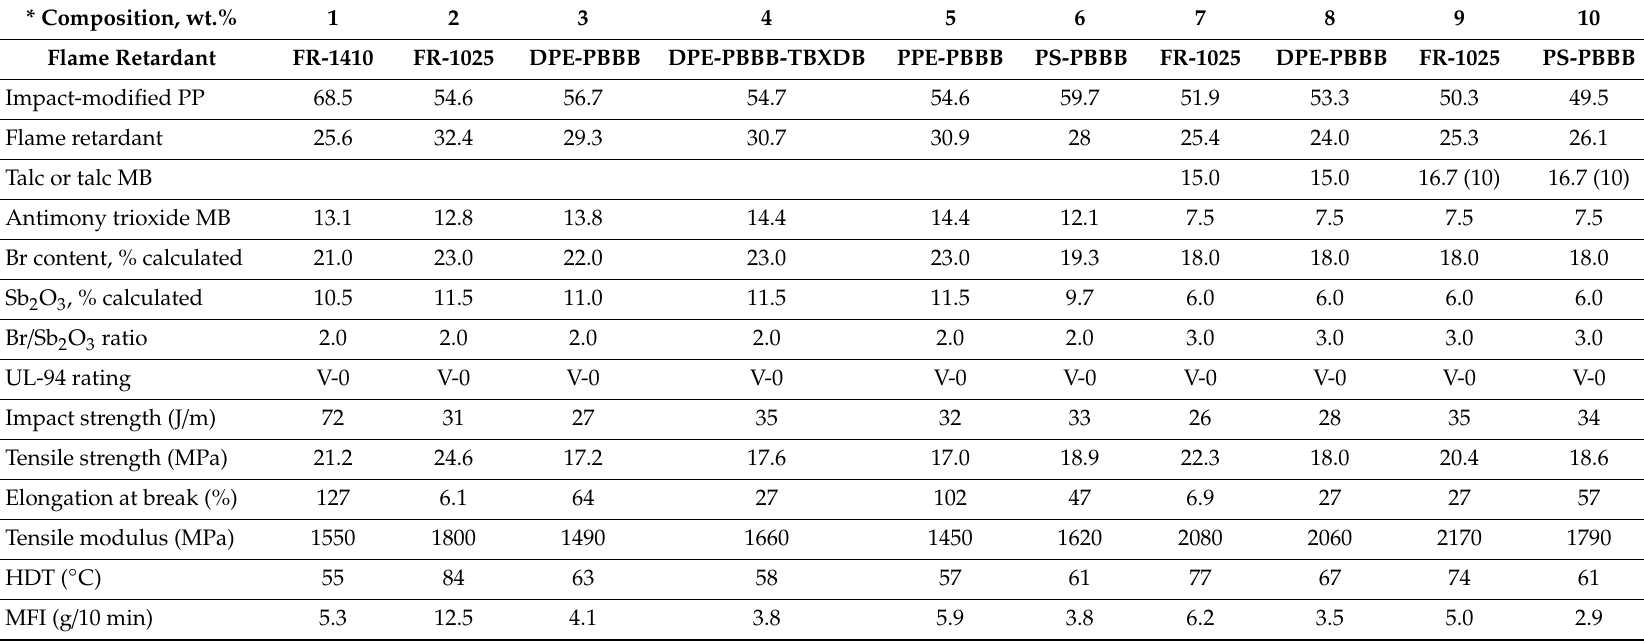
Table 3. Flammability performance and physical properties of impact-modified PP. Legend: HDT, heat distortion temperature; MFI, melt flow index. * Composition,